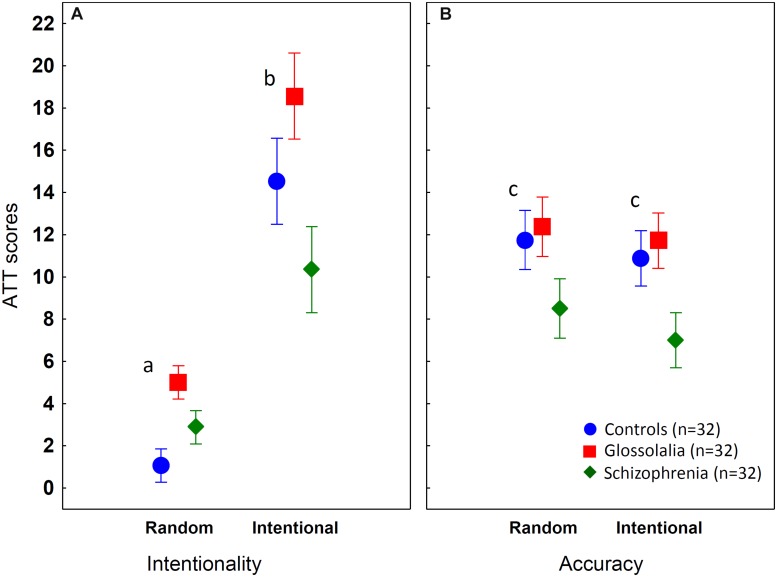
Results from the Animated Triangle Test (ATT) (A - intentionality and B - accuracy). The graphs show mean values, the error bars indicate 95% confidence intervals. aControls < Schizophrenia < Glossolalia; bSchizophrenia < Controls < Glossolalia (ps < 0.05); cSchizophrenia < Controls = Glossolalia (all significant differences at ps < 0.05, Tukey’s HSD tests).